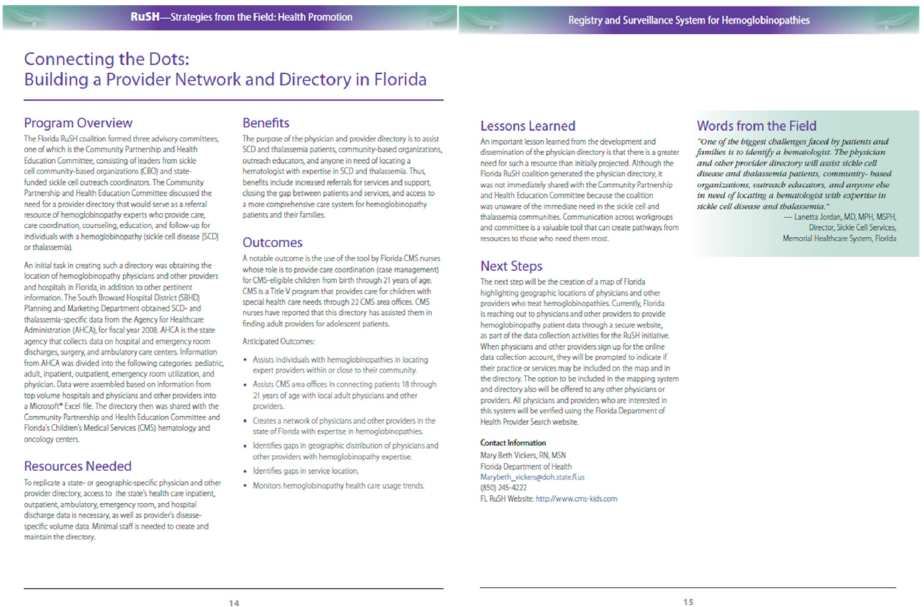
Figure 3. Data source for interactive analytics of public health aspects of sickle cell disease. Each report from a RuSH site included the program overview, resources needed, benefits, outcomes, lessons learned and next steps.